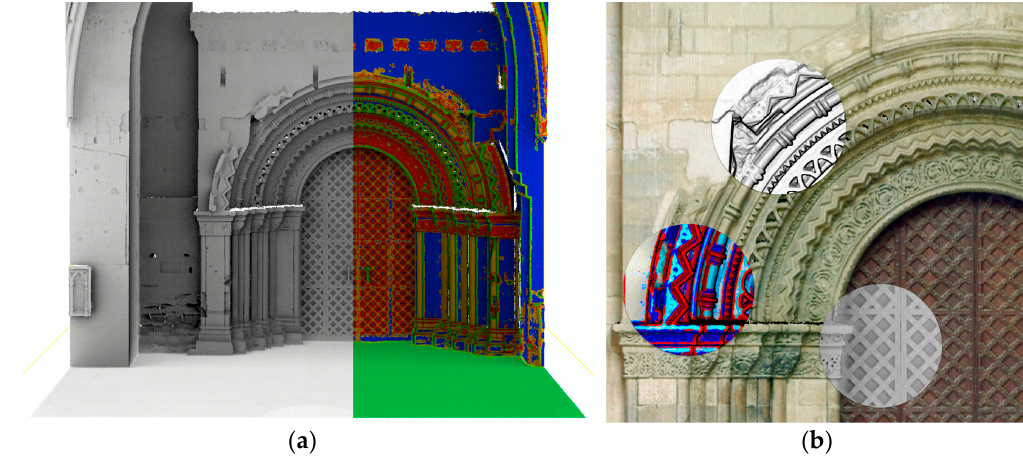
Figure 5. Layers of information in: ( a ) 3D point cloud information with factor scales: ambient occlusion and classification; ( b ) superimposed raster images.